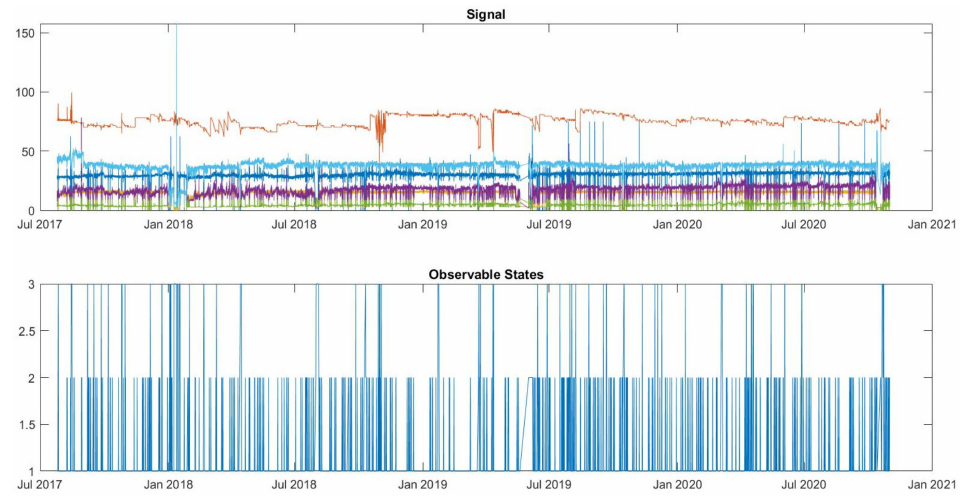
Figure 7. Observable states of equipment over time with K-means